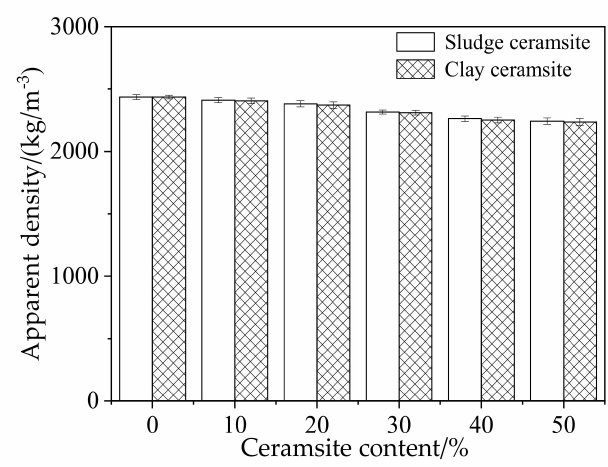
Figure 6. Apparent density of ceramsite cement concrete.